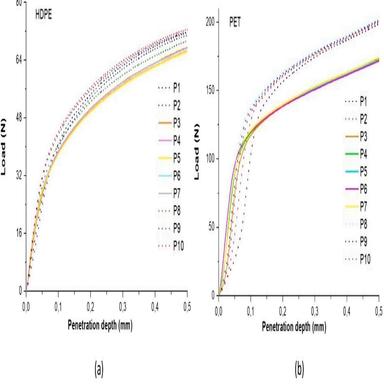
Results of FIMEC test on HDPE (a) and PET (b).